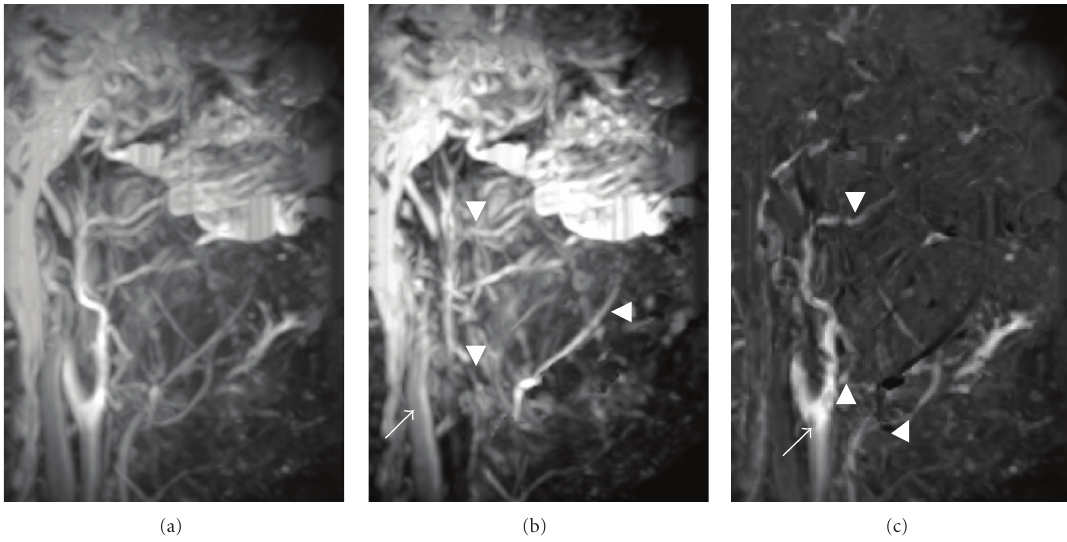
Figure 6: MRA by 3D-FBI in the oral and maxillofacial regions of a 49-year-old healthy volunteer. MRA using 3D-FBI can distinguish between arteries (a) and veins (b) without the use of contrast medium. (a) Images acquired during diastole. The carotid artery, internal jugular vein, maxillary artery, maxillary vein, facial artery, facial vein, lingual artery, and lingual vein are visualized. Acquisition time was 3 minutes and 36 seconds. (b) Images acquired during systole. The internal jugular vein (arrow), maxillary vein (arrowhead), facial vein (black arrowhead), and lingual vein (gray arrowhead) are depicted. Acquisition time was 3 minutes and 36 seconds. (c) The subtraction image of the systolic image (b) from the diastolic image (a) that depicts the carotid (arrow), maxillary (arrowhead), facial (black arrowhead), and lingual arteries (gray